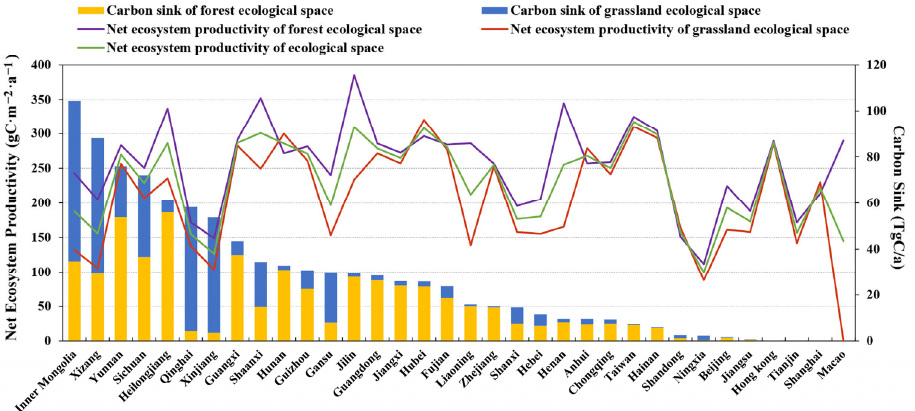
Figure 4. Average NEP and CS at the provincial scale in China.